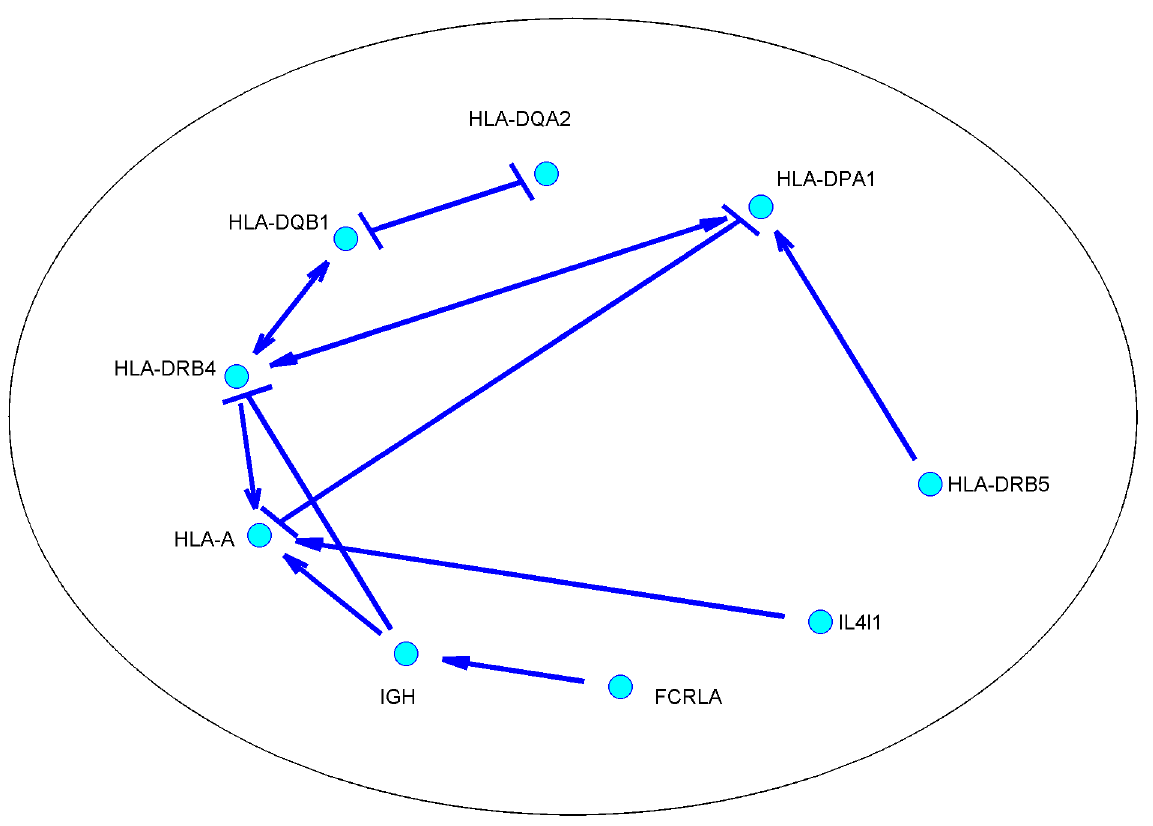
Figure 6. The network of 39 human genes inferred from gene expression and eQTL data with the SML algorithm. The 39 genes related to the immune function were chosen from [45] to have a reliable eQTL per gene. The SML algorithm was run with stability selection and edges were detected at an FDR v 0 : 1 . See Table 3 for the IDs and description of 39 genes. IGH in this figure corresponds to gene ID ENSG00000211897. A a edge stands for inhibitory effect and a ? edge stands for activating effect.